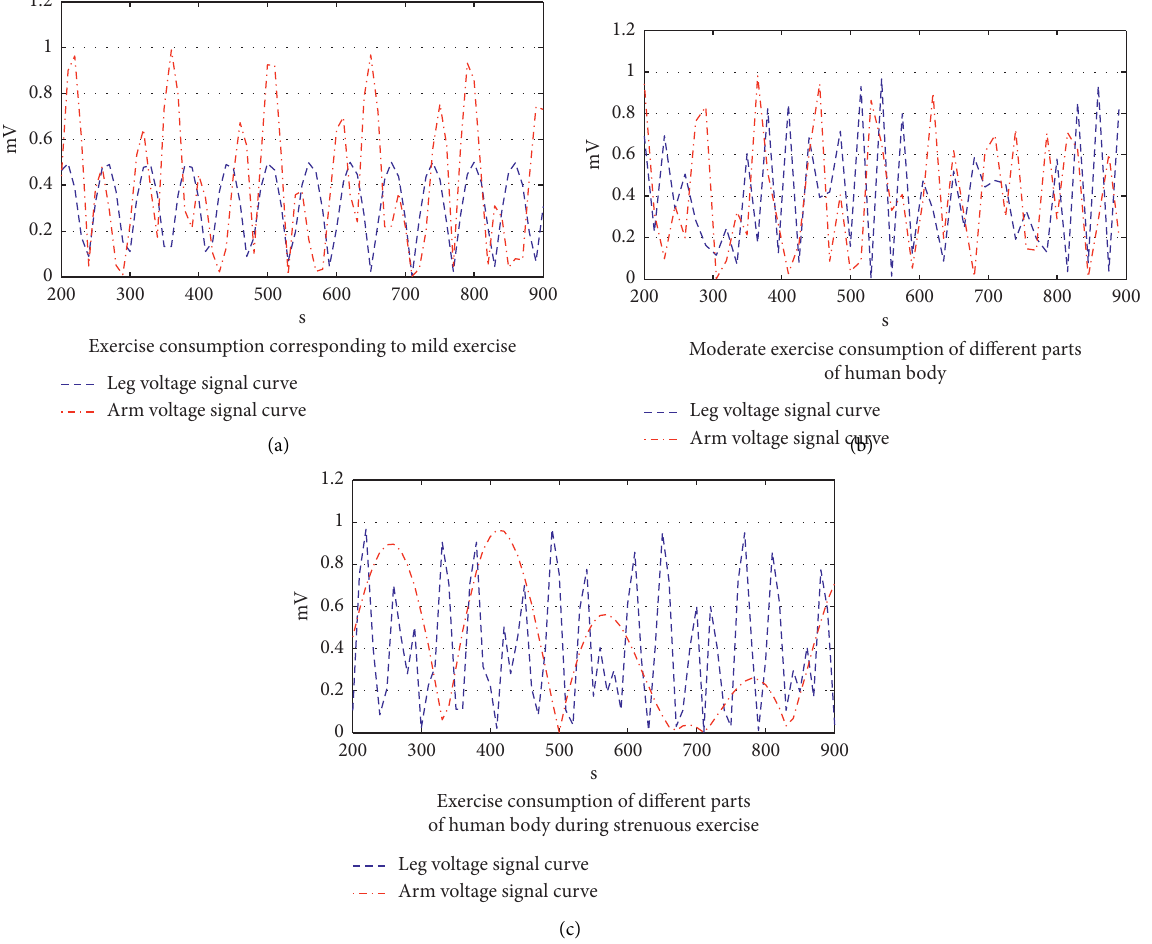
Figure 9: Waveform of voltage consumed by different parts of the human body of wearable intelligent